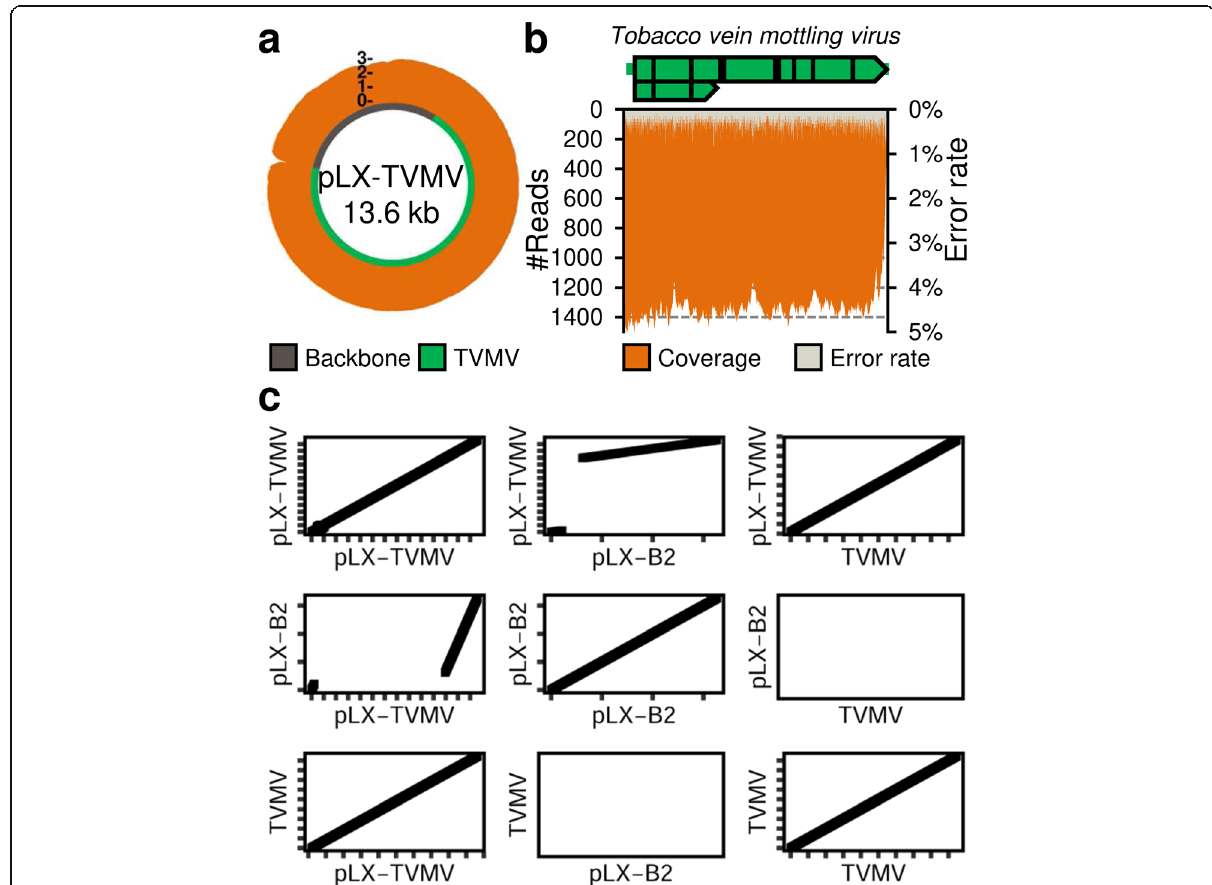
Fig. 2 One-step verification of complete Potyvirus clone sequence by Illumina sequencing. a The sequence of the 13.6-kb pLX-TVMV vector was verified using the Illumina platform and de novo read assembly; the read coverage (log10), vector backbone and TVMV sequences are indicated. b The sequencing depth (read number, orange) and error rate (gray) of the TVMV genome assembled are plotted. c Dot plots show significant DNA alignments between pLX-TVMV (this study, GenBank: MW027845) and pLX-B2 (GenBank: KY825137) or a TVMV reference genome (GenBank: X04083); axis ticks indicate 1-kb